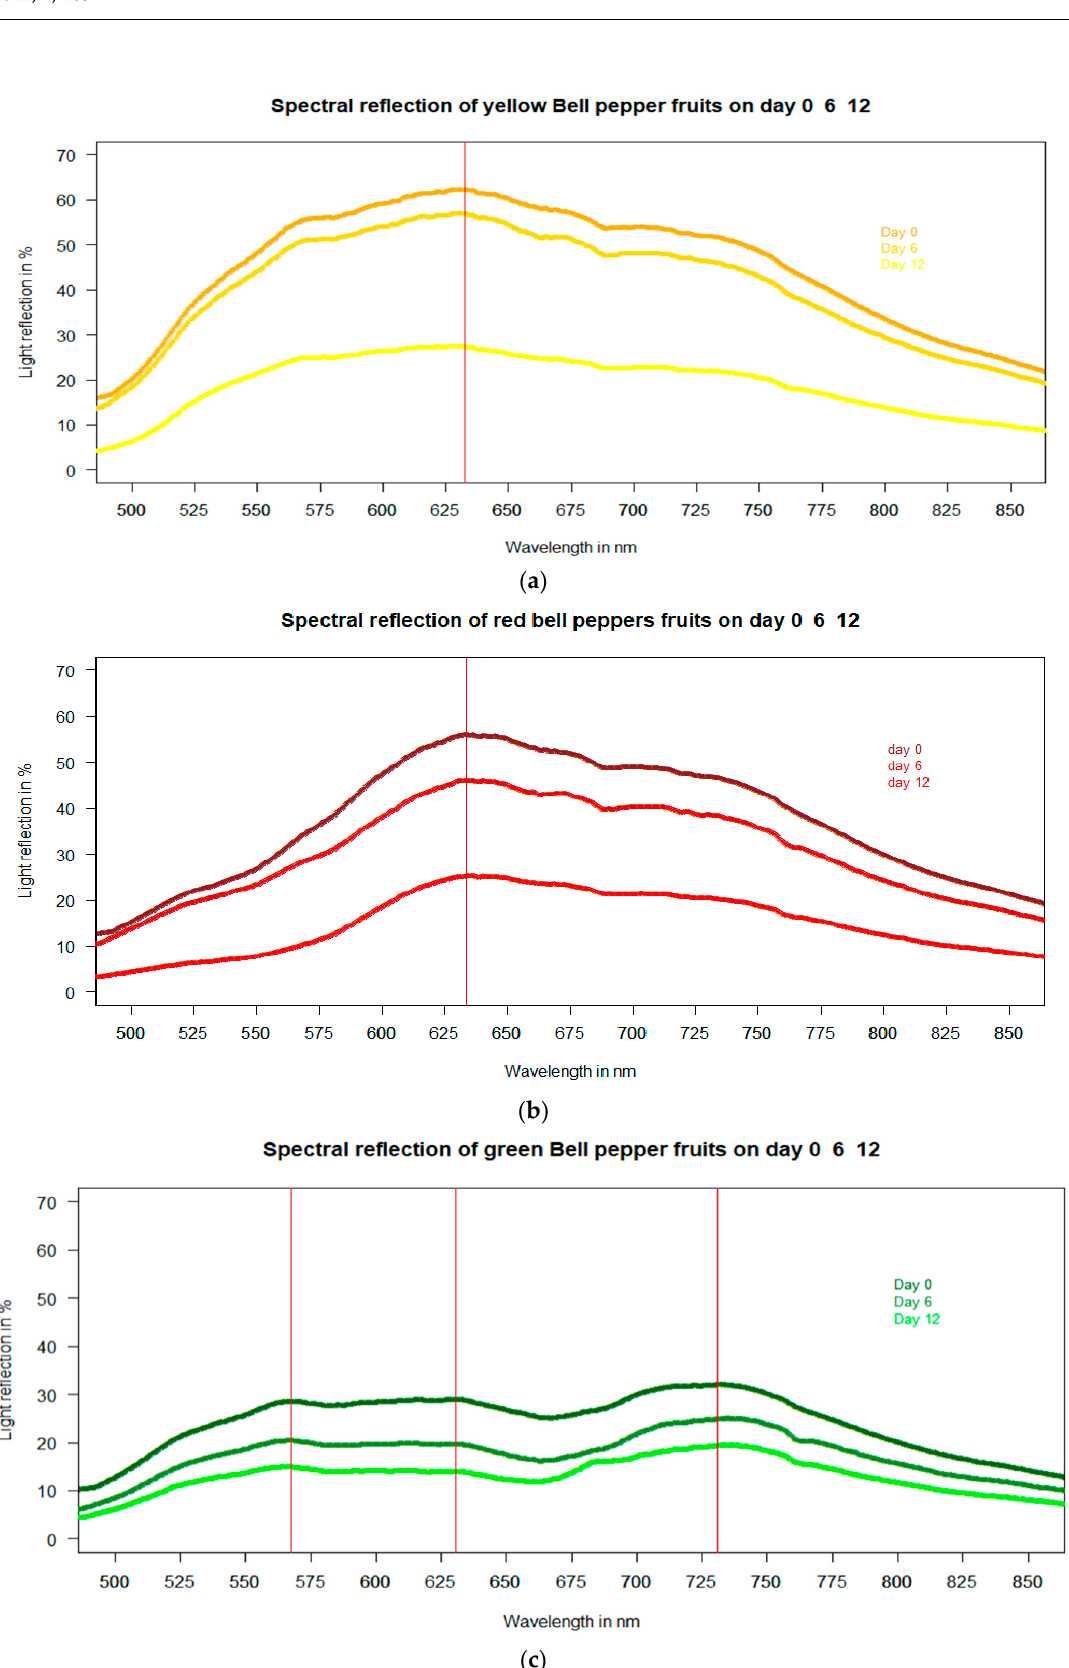
Figure 5. Percentage spectral light reflection of ( a ) yellow, ( b ) red, and ( c ) green bell pepper fruits in three stages of freshness (shriveling and storage day 0 = fresh fruit, day 6 = shrivel level 2, day 12 = shrivel level 4) (barium sulfate = 100% light reflectance) ( n = 20 fruit per colour, i.e., per curve; n = 60 overall—from Althaus and Blanke, 2020, with permission).